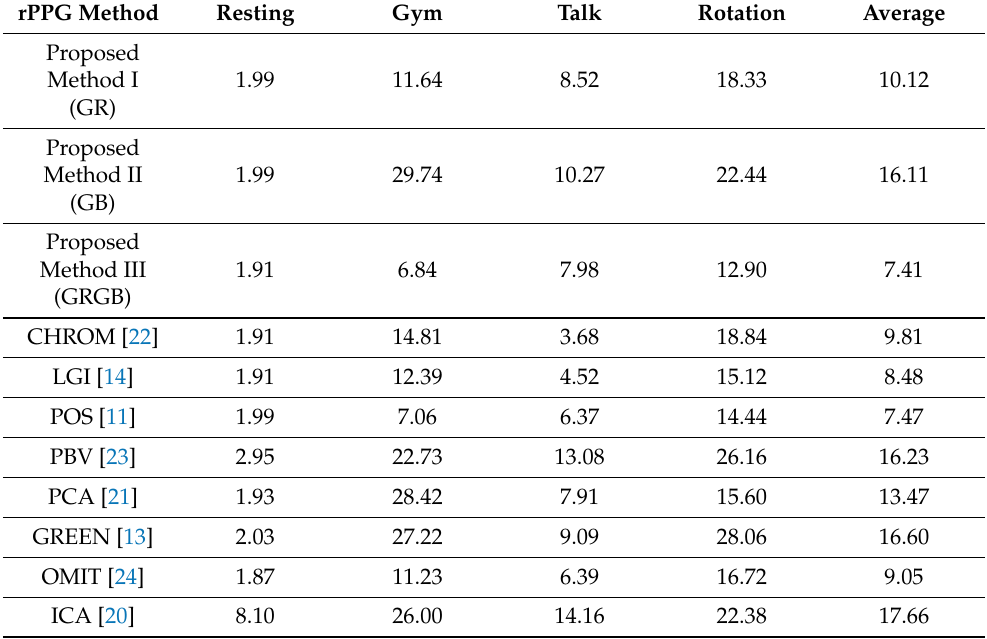
Table 2. Average | ∆ BPM| for each video setting and rPPG method. A small | ∆ BPM| means that the calculated BPM from the PPG and rPPG signals are in high agreement. rPPG